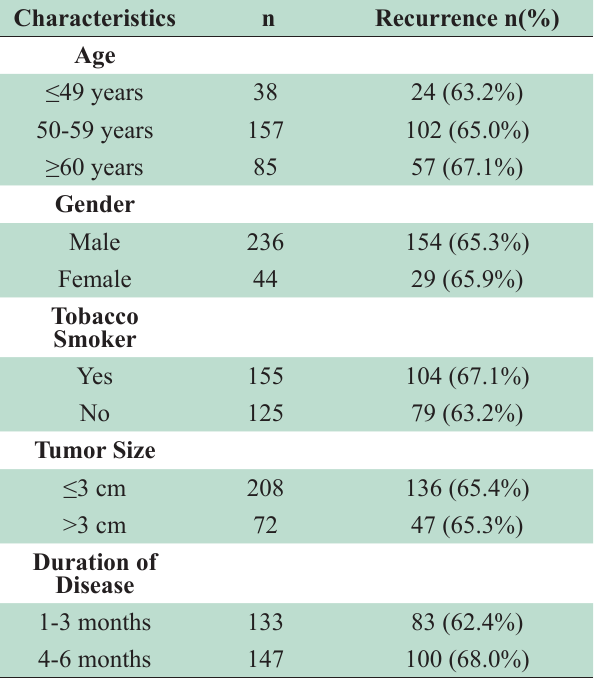
Table-IV: Frequency of Tumor Recurrence across various Subgroups n=280.